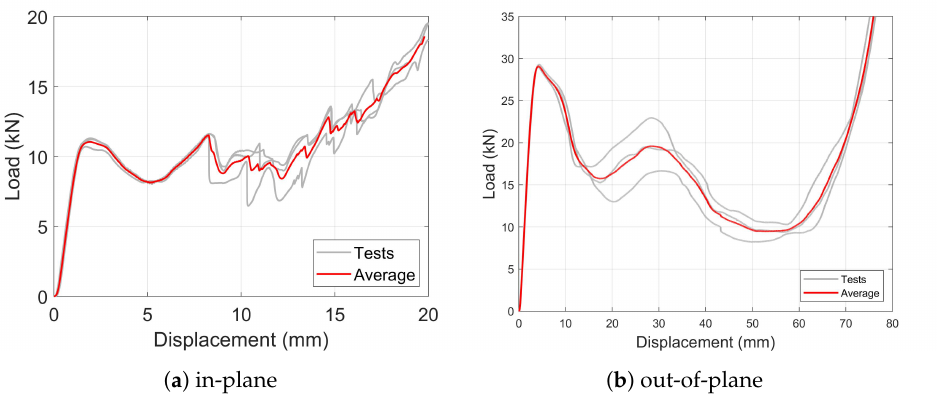
Figure 8. Load–displacement curves related to the in-plane and out-of-plane crush of chiral lattices. Table 5. Properties of the chiral structure under in-plane and out-of-plane crushing.